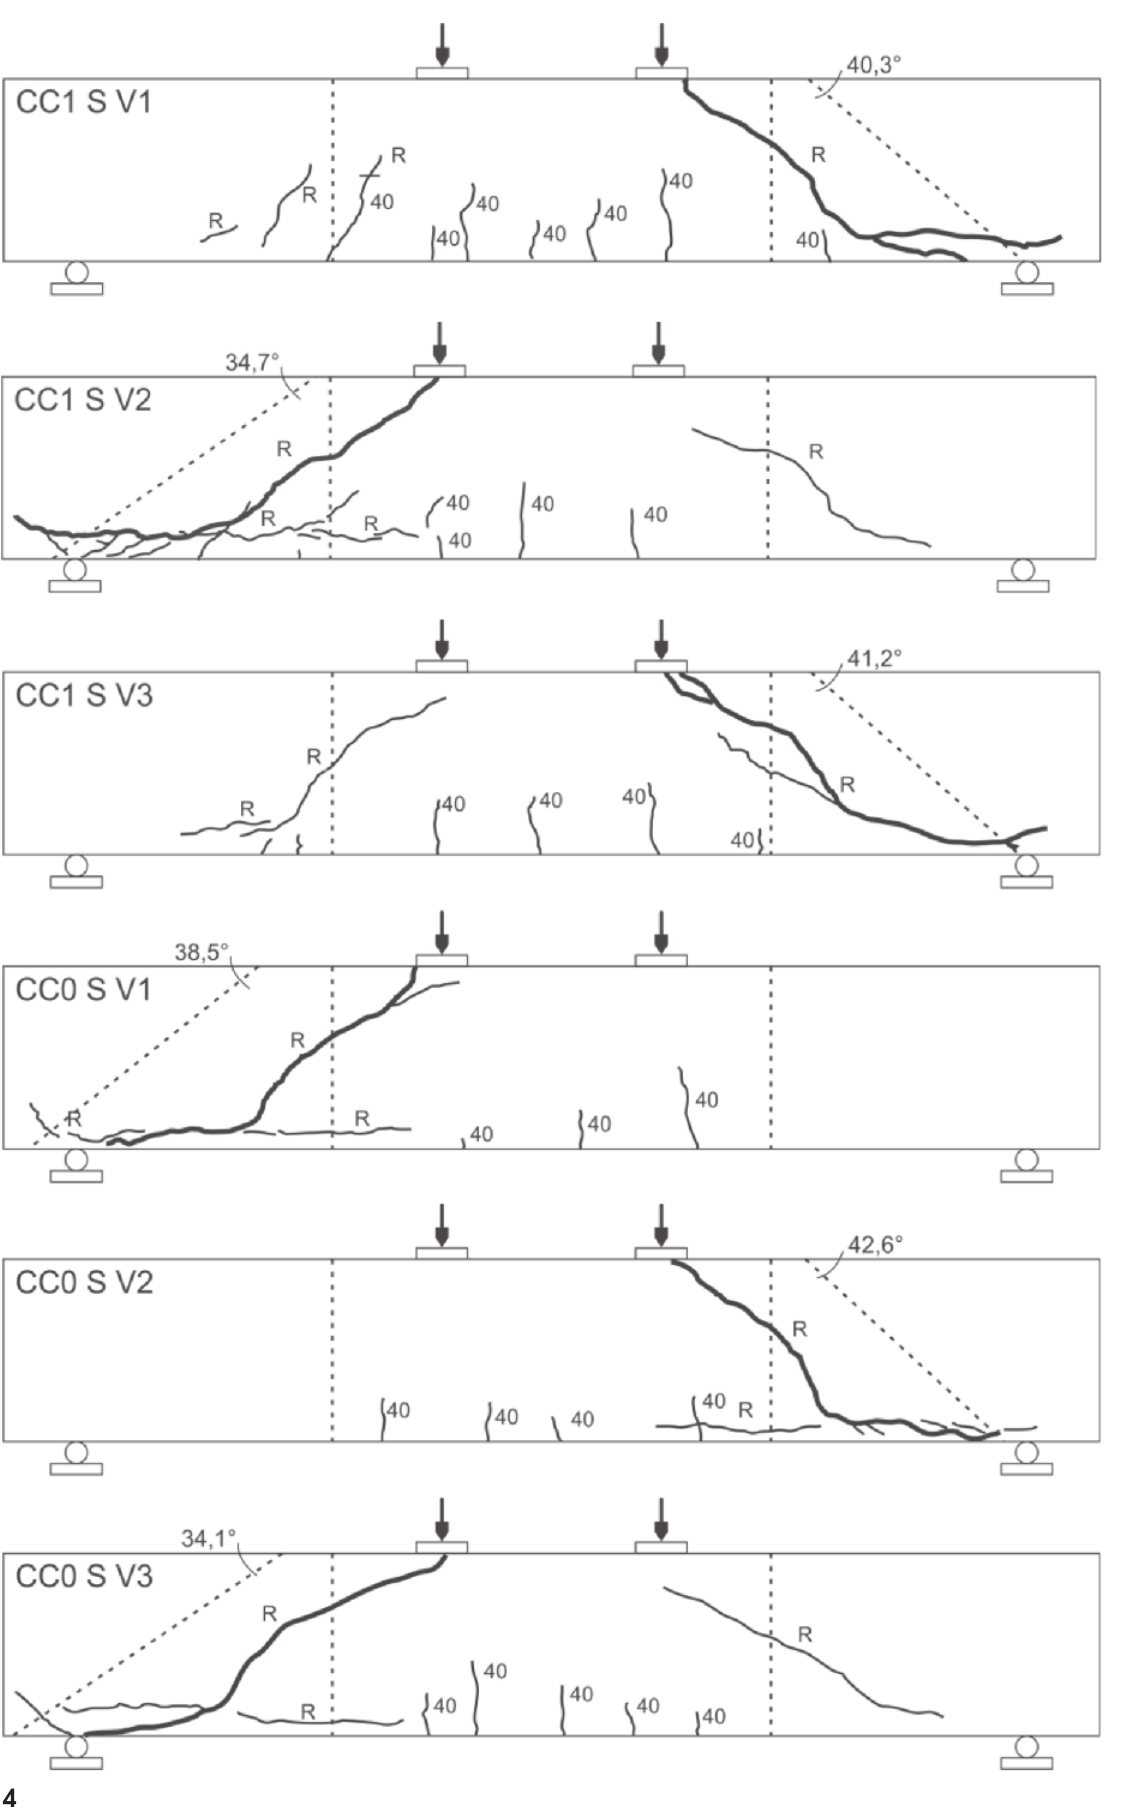
Crack patterns of conventional concrete